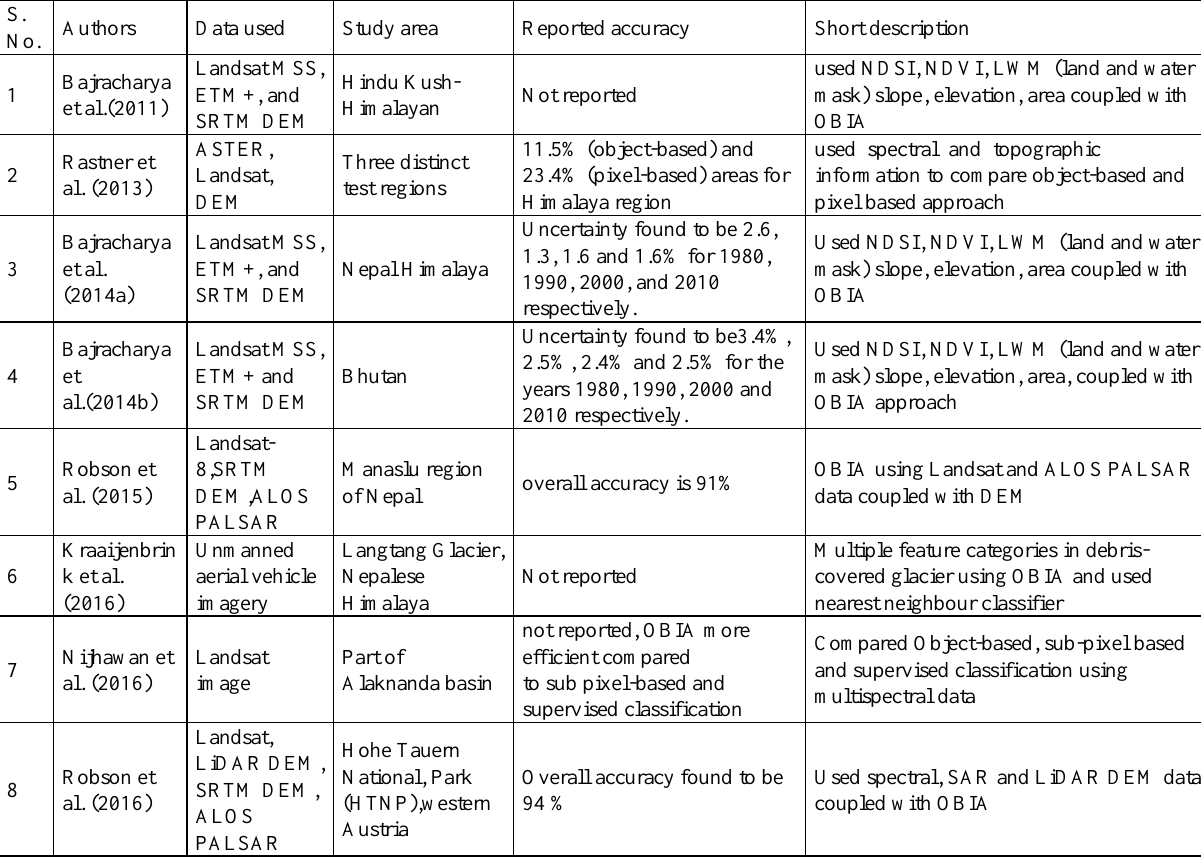
Table 2. OBIA for delineation of debris-covered glaciers